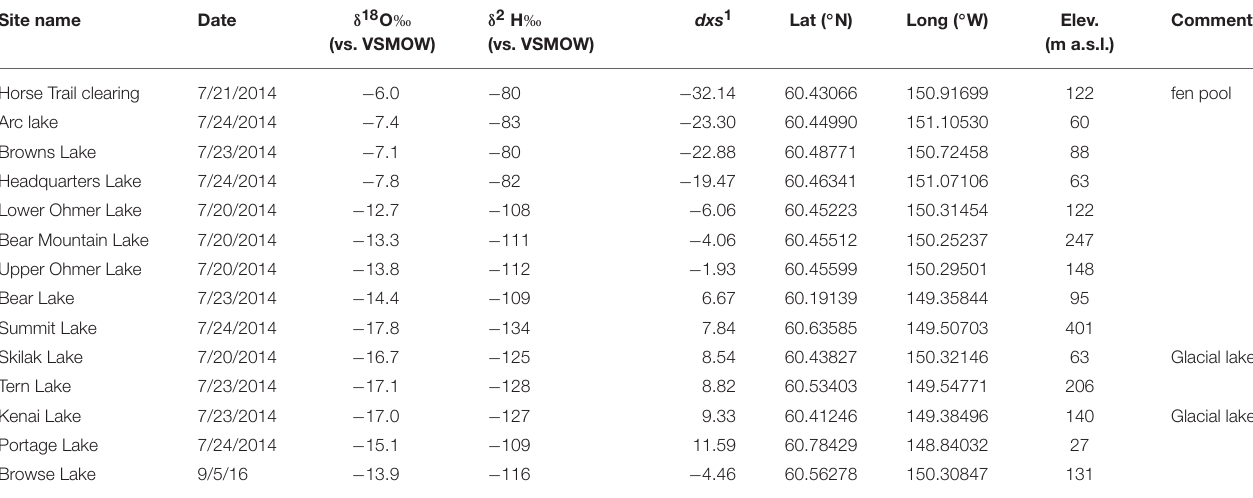
TABLE 1 | Kenai lake water isotope